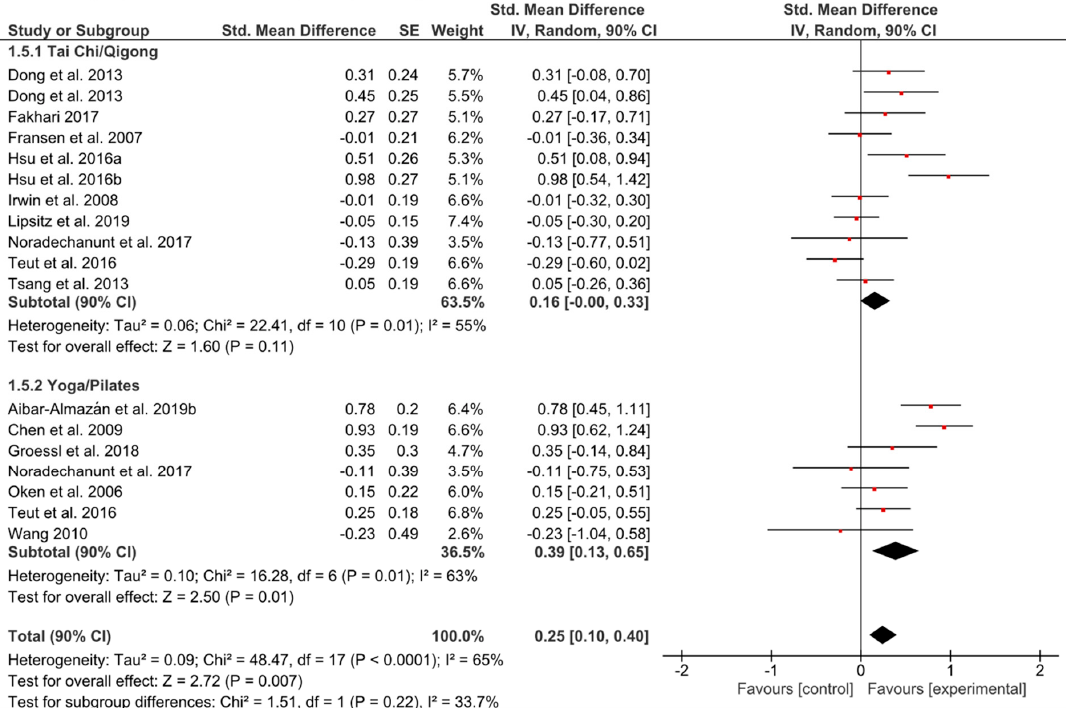
Figure 6. Standardized mean effects of mind–body interventions on depressive symptoms compared to a non-exercise control group. Data are separately presented for Tai Chi/Qigong and Yoga/Pilates. SE: standard error; IV: inverse variance model; CI: confidence interval; Std.: standardized.